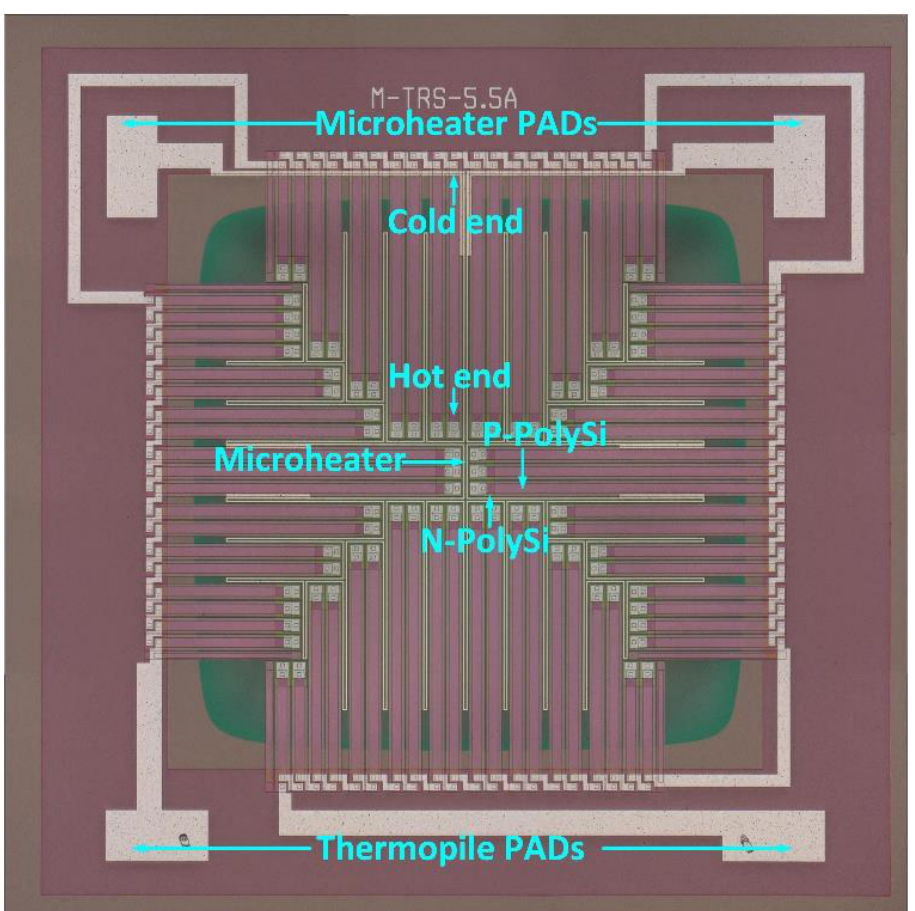
Figure 3. Microscope image of the MEMS thermopile with a microheater.